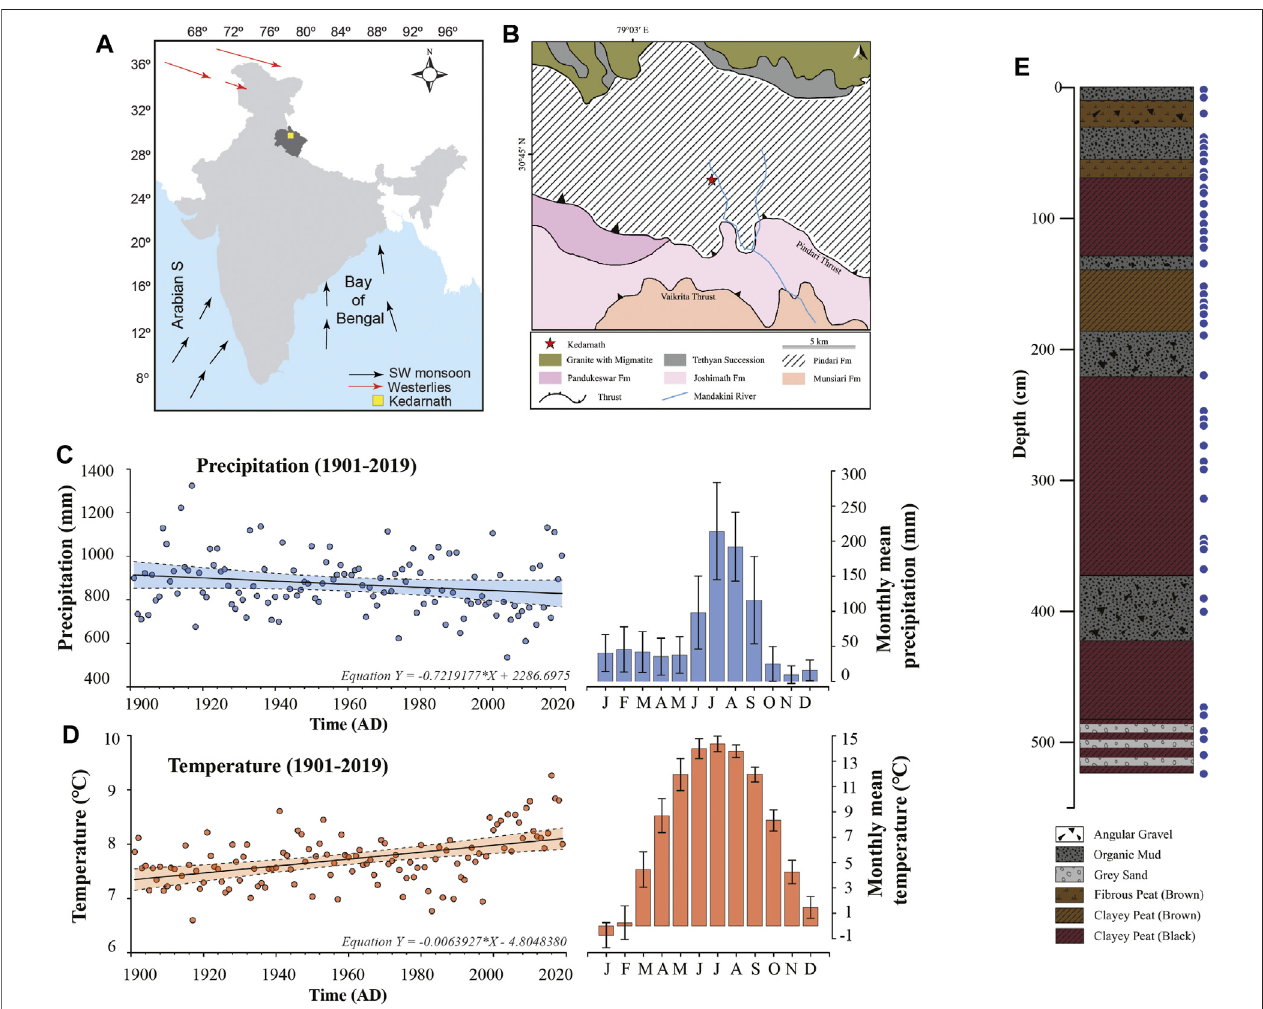
FIGURE1|(A) LocationofthestudyareaintheIndiansubcontinent. (B) ThegeologicalmapshowingthesamplinglocationofthepeatsuccessionintheKedarnath region of Uttarakhand (marked with the red star). (C) The long term decreasing trend in the mean precipitation in Kedarnath region from Climate Research Unit (CRU TS v4.03) for the period 1901 – 2019 interpolated into 0.5 ° latitude/longitude gridded cell. The shaded region represents 99% con fi dence interval. (D) The long term increasing trendin the mean temperature in Kedarnathregion from Climate Research Unit (CRU TSv4.03) for theperiod 1901 – 2019interpolated into 0.5 ° latitude/ longitudegriddedcell.Theshadedregionrepresents99%con fi denceinterval. (E) Thelitho-columndepictingthesedimentarylayersacrossthestudieddepthalongwith the analyzed samples marked with solid blue circles.